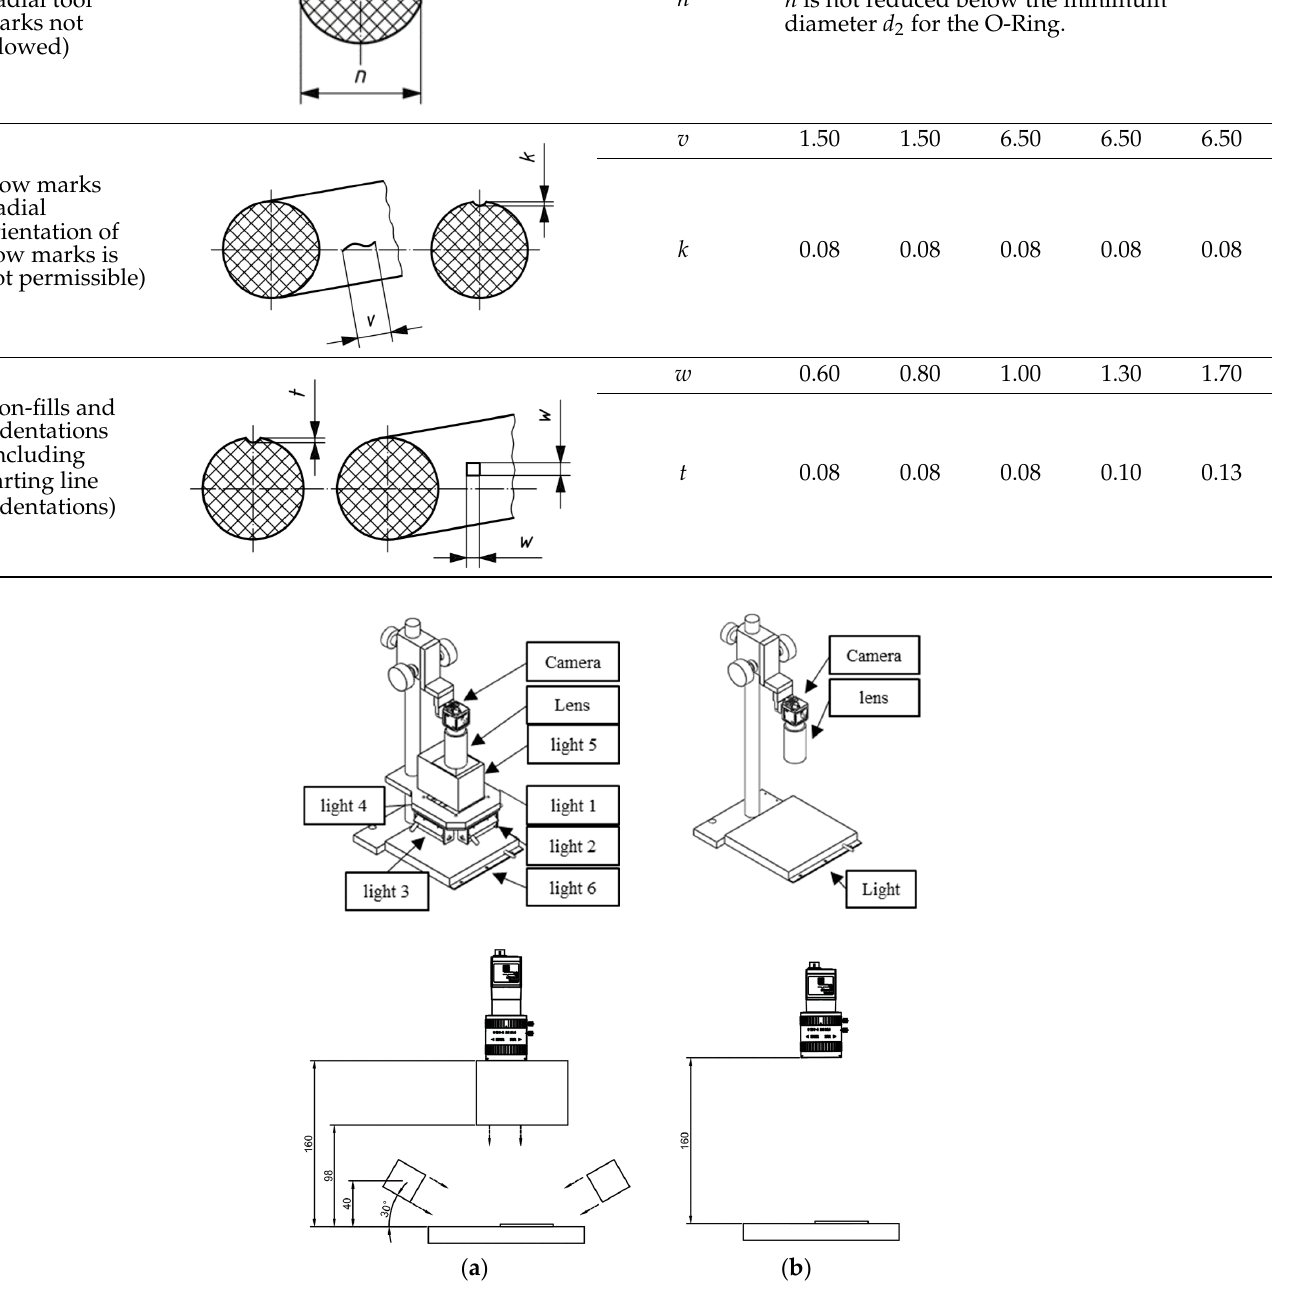
Figure 3. There are two mechanisms in this paper: ( a ) Defect detection system; ( b ) dimension measurement